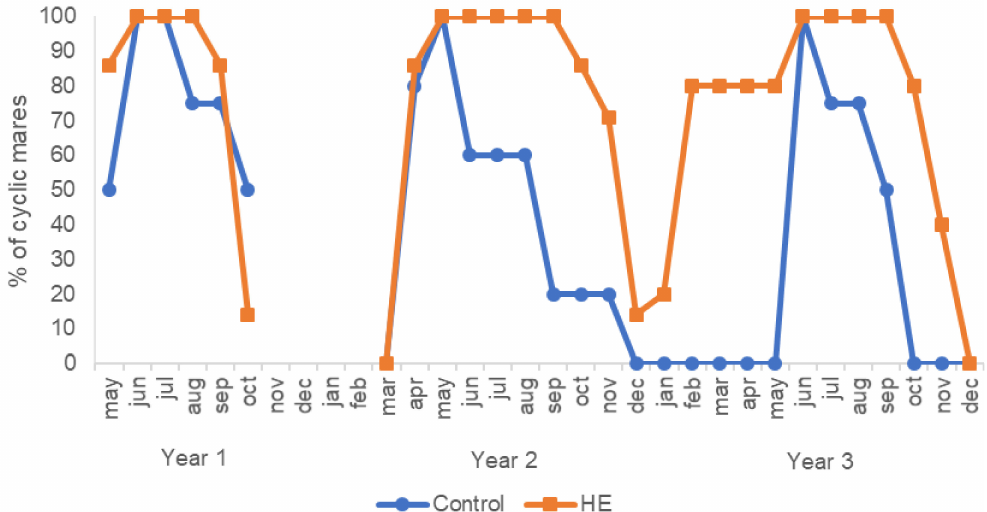
Figure 2. Percentage of cyclic mares per month for the control (maintenance diet) and high-energy (HE; diet equating to 200% of net energy requirements) groups during study years 2014–2016 (years 1–3). Measurements were stopped from November 2014 until March 2015. Year 1: n = 4 control and 7 HE mares; Year 2: n = 5 control and 7 HE mares; Year 3: n = 4 control and 5 HE